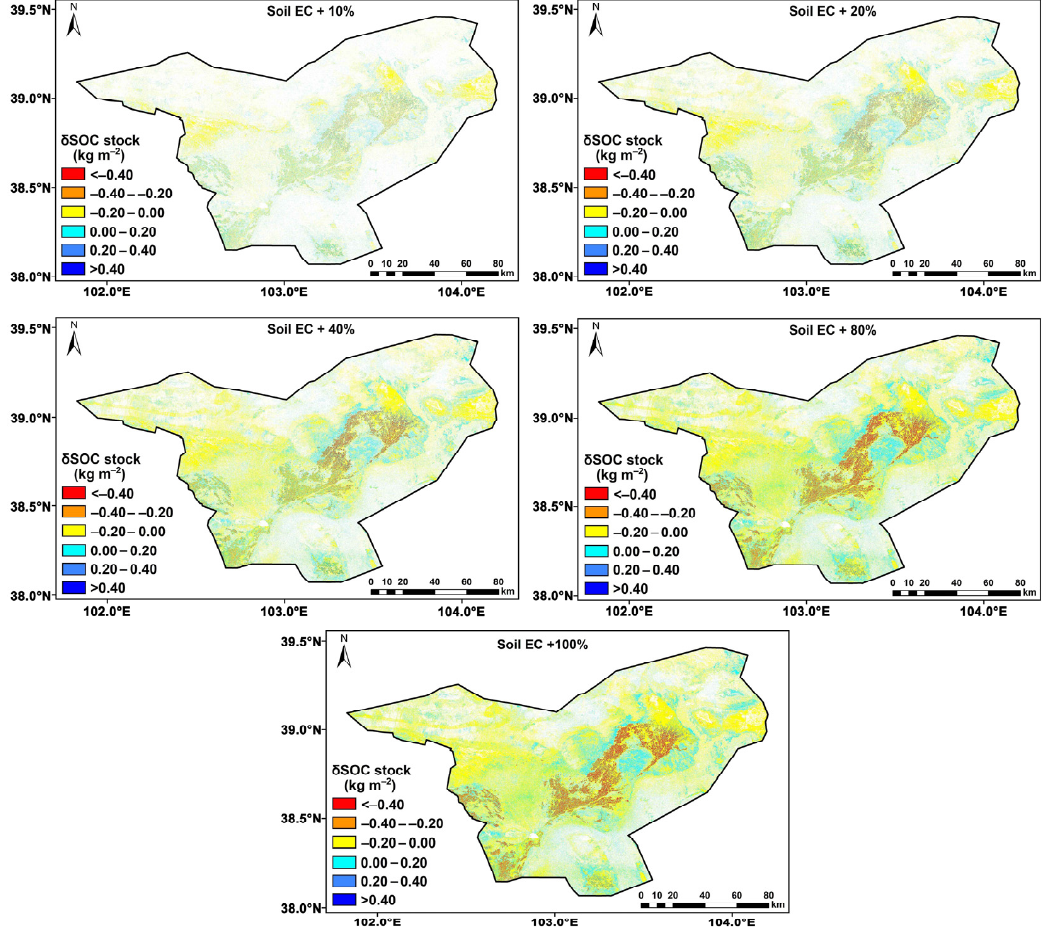
Figure 9. Spatial distribution of δ SOC stock (differences between the scenario and baseline) derived from 30 runs of the XGBoost models under different salinity increase scenarios. Note: ‘EC +’ indicates increased soil salinity.